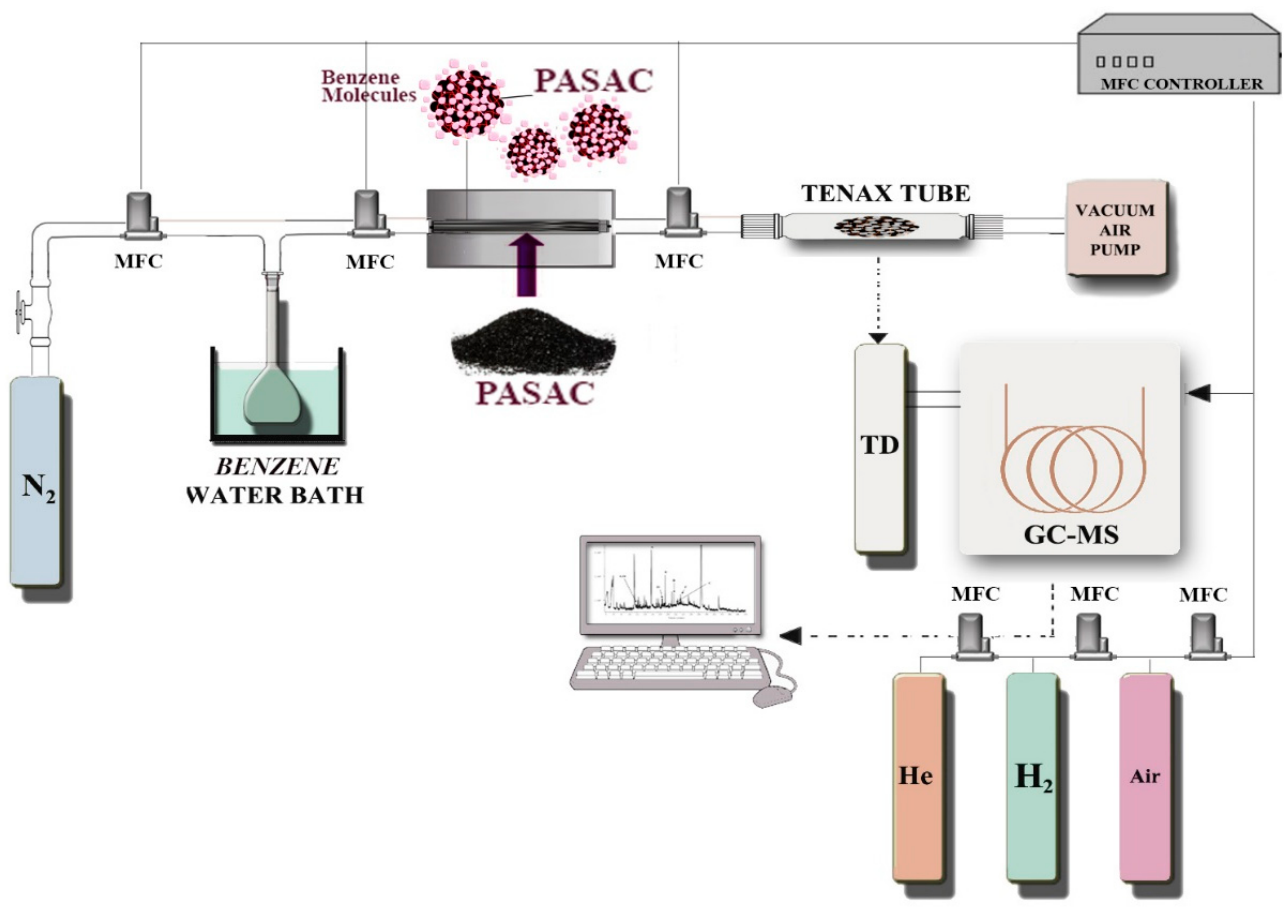
Figure 8. Schematic diagram of benzene removal.